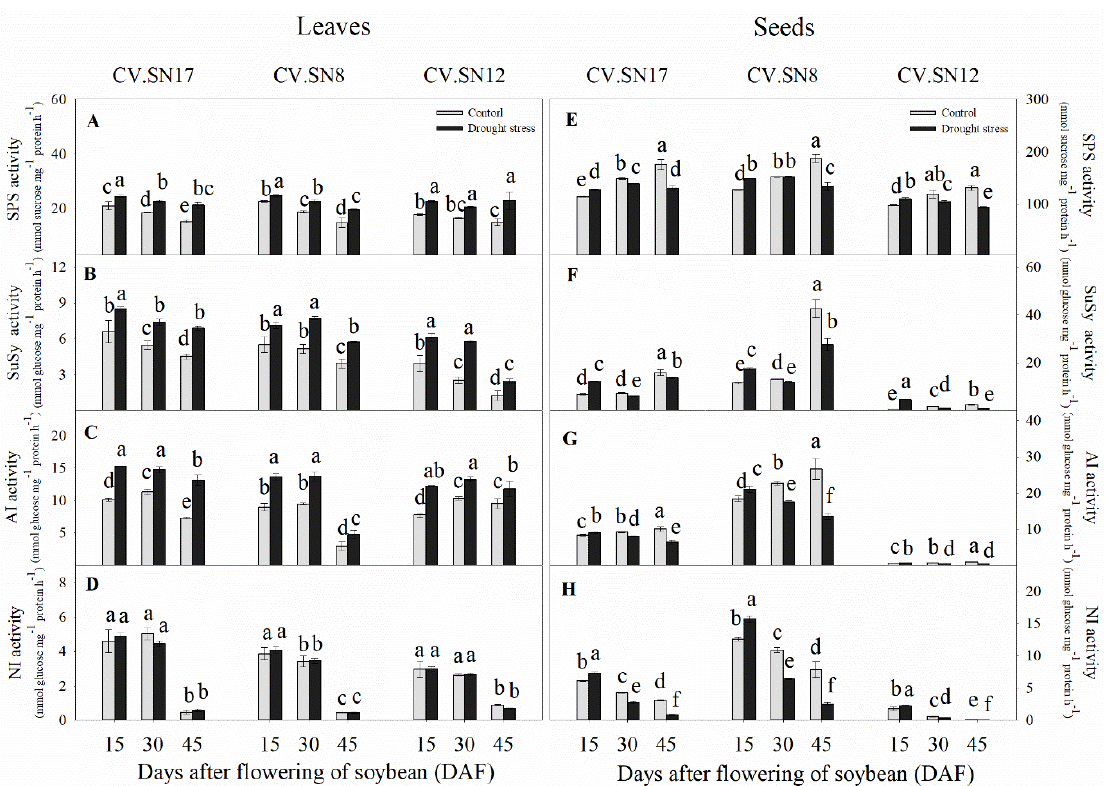
Figure 4. Effect of drought stress on the enzyme activity levels of ( A , E ) sucrose phosphate synthase (SPS), ( B , F ) sucrose synthase (SuSy), ( C , G ) acid invertase (AI), and ( D , H ) neutral/alkaline invertase (NI) in leaves and seeds. Standard deviations were calculated with three independent experiments each comprising two soybean plants. Different letters above vertical bars indicate significant differences between means at a p < 0.05 level.